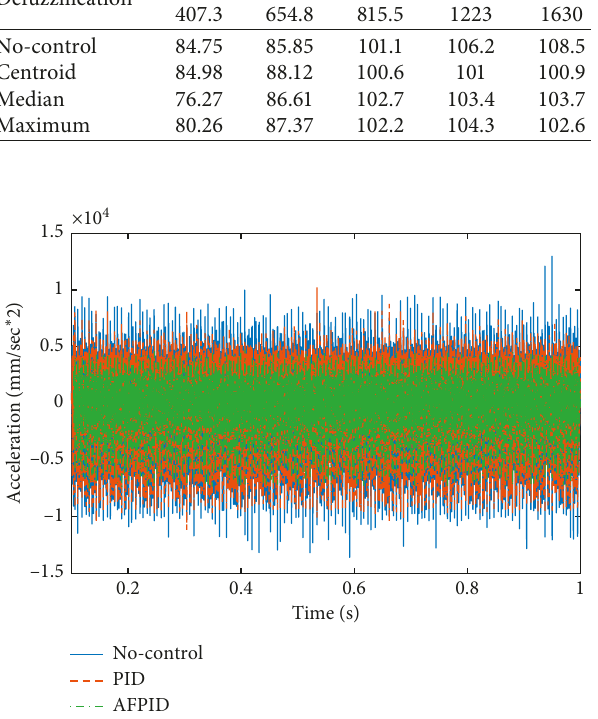
Figure 12: Active control of vibration in the time domain of gear transmission system.